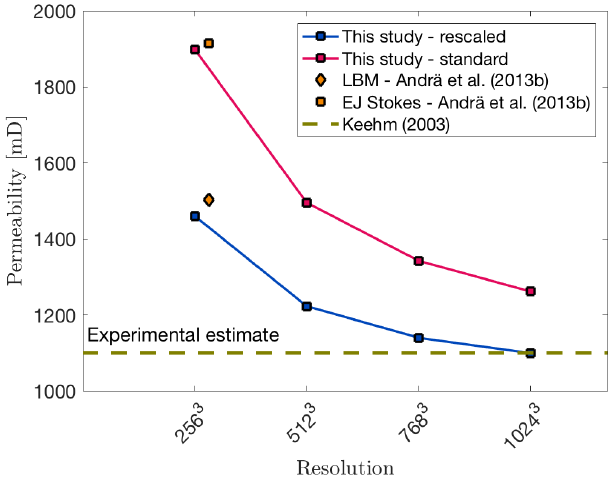
Figure 8. Computed permeability values against grid resolu- tion. Orange symbols denote simulations using Lattice–Boltzmann method (LBM) and explicit jump Stokes (EJ Stokes); both methods are used in Andrä et al. (2013b). Blue data points represent simula- tions using stencil rescaling, while simulations represented by red dots use the standard method. The brown dotted line symbolizes the experimental estimate from Keehm